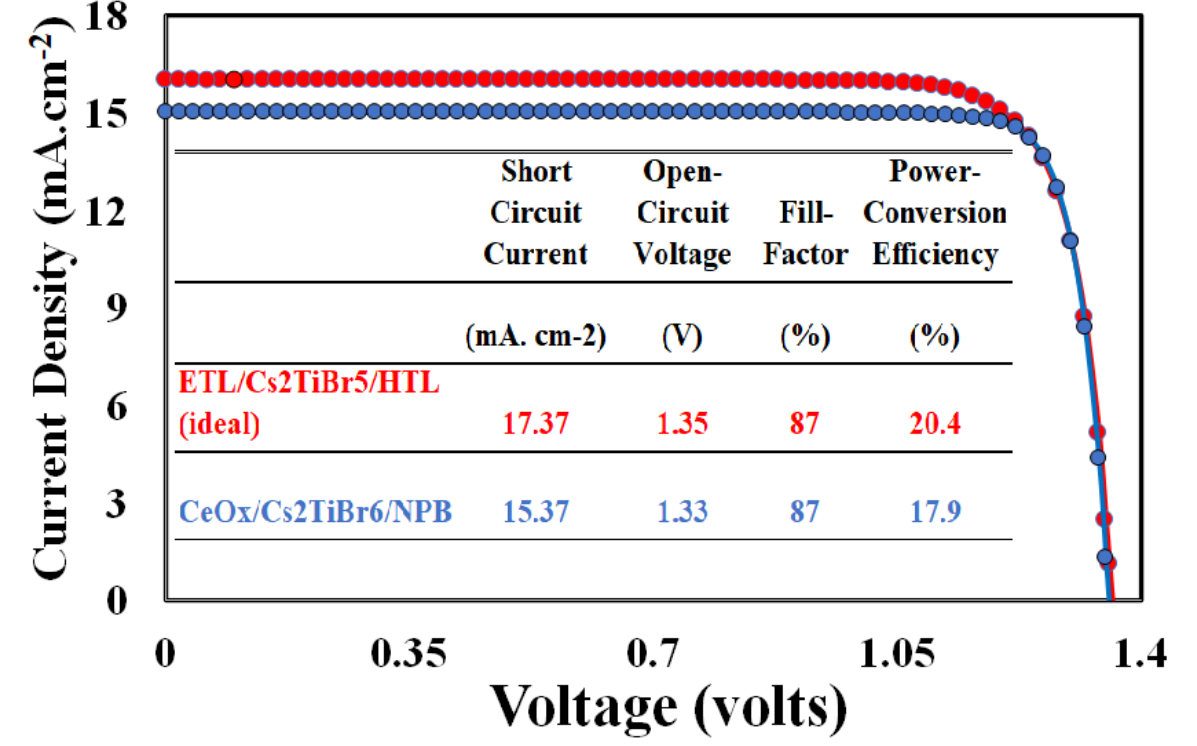
Figure 9. Photo current-voltage response of ETL/Cs2TiBr6/HTL and CeOx/Cs2TiBr6/NPB solar cells. The inset lists the photovoltaic parameters such as short-circuit current, open-circuit voltage, fill factor, and PCE for both solar cells.